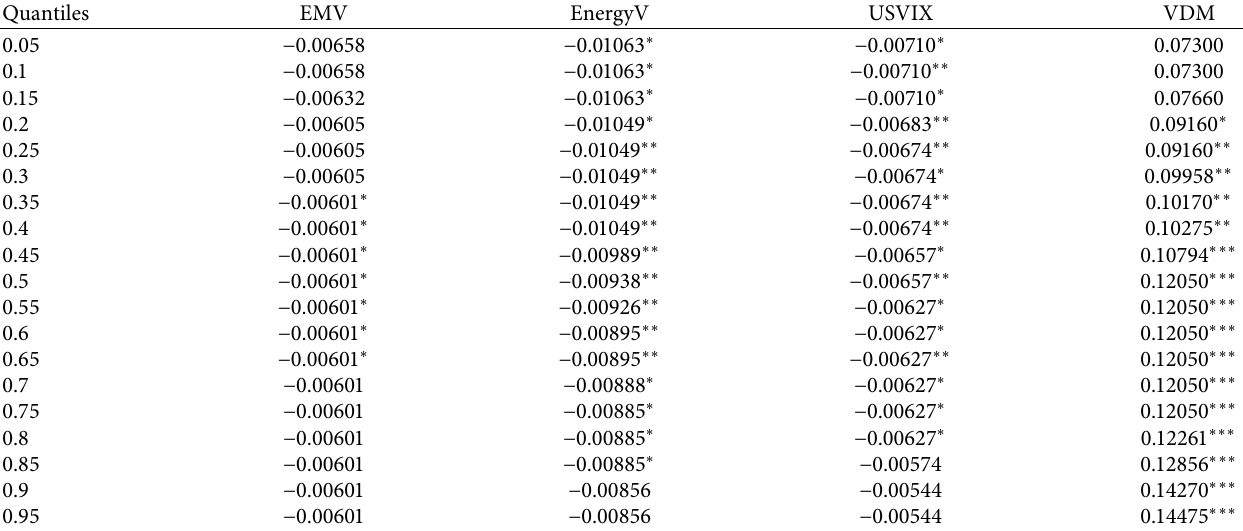
Table 8: Effect of volatilities on